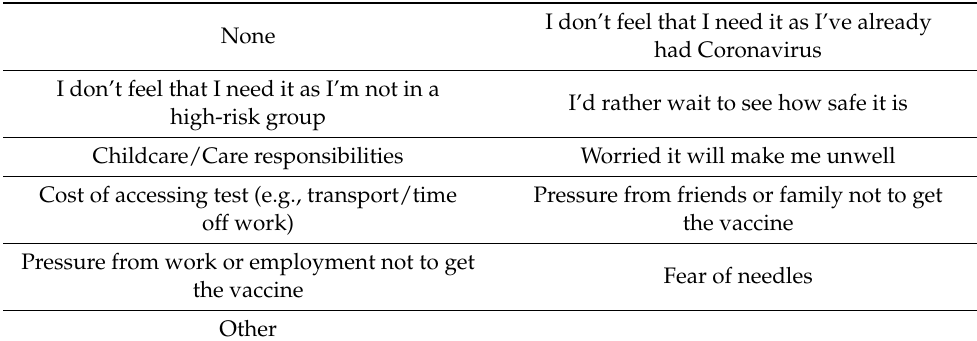
Table A5. What are the practical challenges you face, or have faced, getting vaccinated for the Coronavirus (COVID-19)? (please tick all that